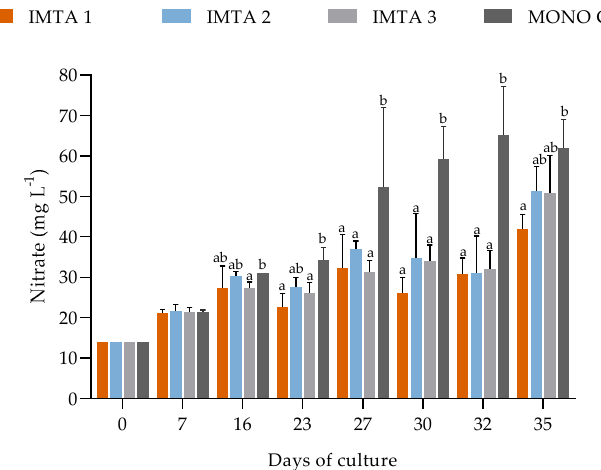
Figure 3. Variations in the nitrate concentrations in the IMTA 1 (with 1 g Ulva L − 1 ), IMTA 2 (2 g Ulva L − 1 ), IMTA 3 (3 g Ulva L − 1 ), and MONO C (with no Ulva) treatment groups during the 35 days of cultivation. a; b = Different lowercase letters represent a significant difference ( p ≤ 0.05) on the same days between the treatments after performing one-way ANOVA followed by Tukey’s post-hoc test.